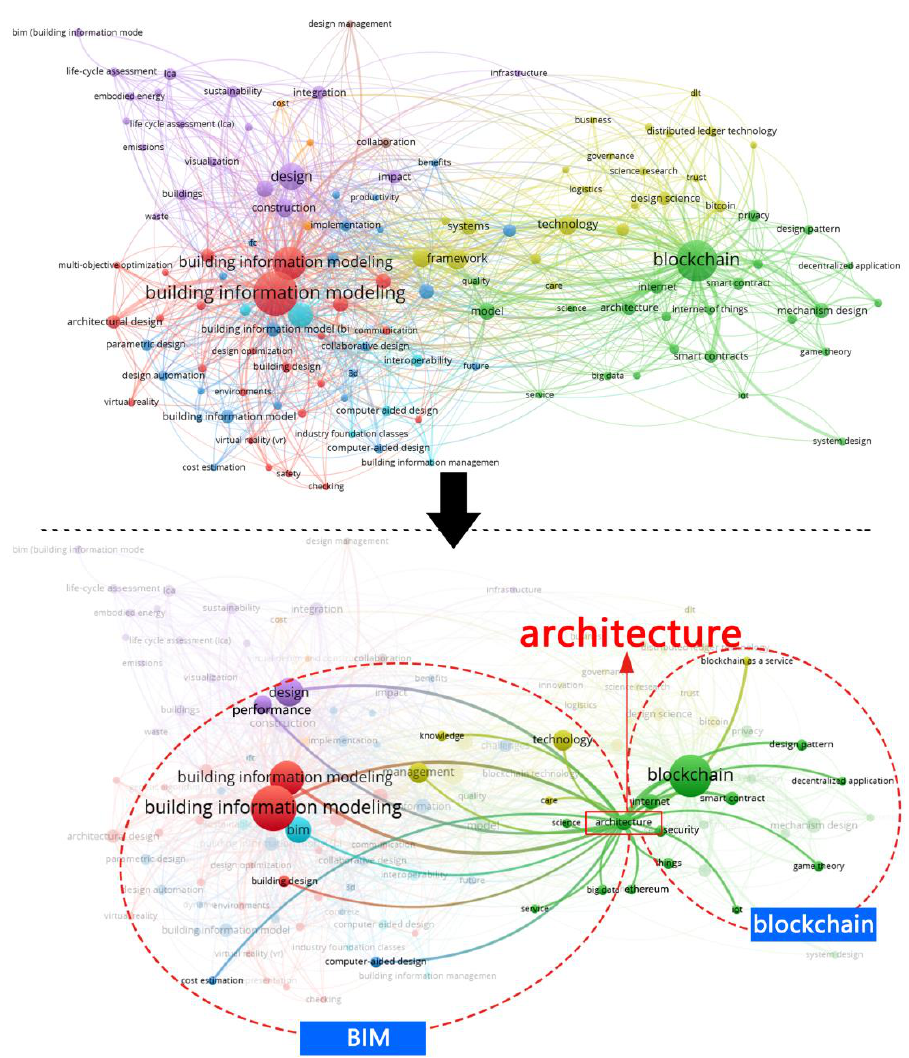
Figure 3. The relationship between BC, building information modeling, and design via VOSviewer software (generated by authors).